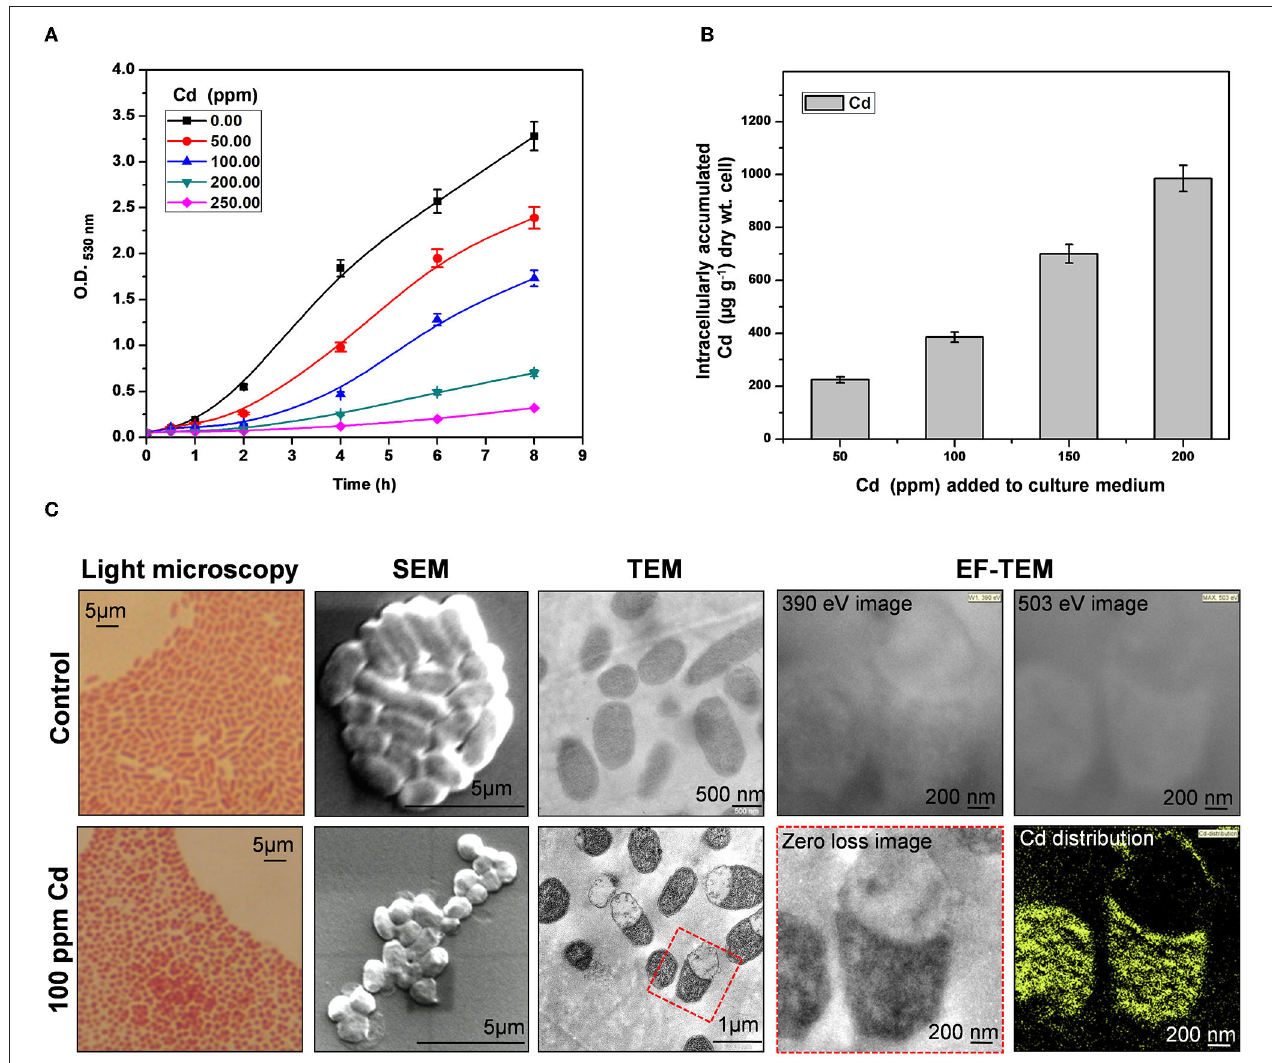
FIGURE 1 | Cadmium (Cd) tolerance and accumulation by Providencia rettgeri . (A) Growth of P. rettgeri in the presence of different concentrations of Cd (0–250 ppm). (B) Cd concentration in P. rettgeri cells grown in the presence of increasing concentrations of Cd for 20h. (C) Morphology of P. rettgeri cells observed under light microscopy, scanning electron microscopy, transmission electron microscopy, and elemental mapping of cadmium using energy-filtered transmission electron microscopy. The P. rettgeri cells were either grown in the presence of 100 ppm Cd or not (control). The red dotted box shows the cells on which EFTEM analysis was carried